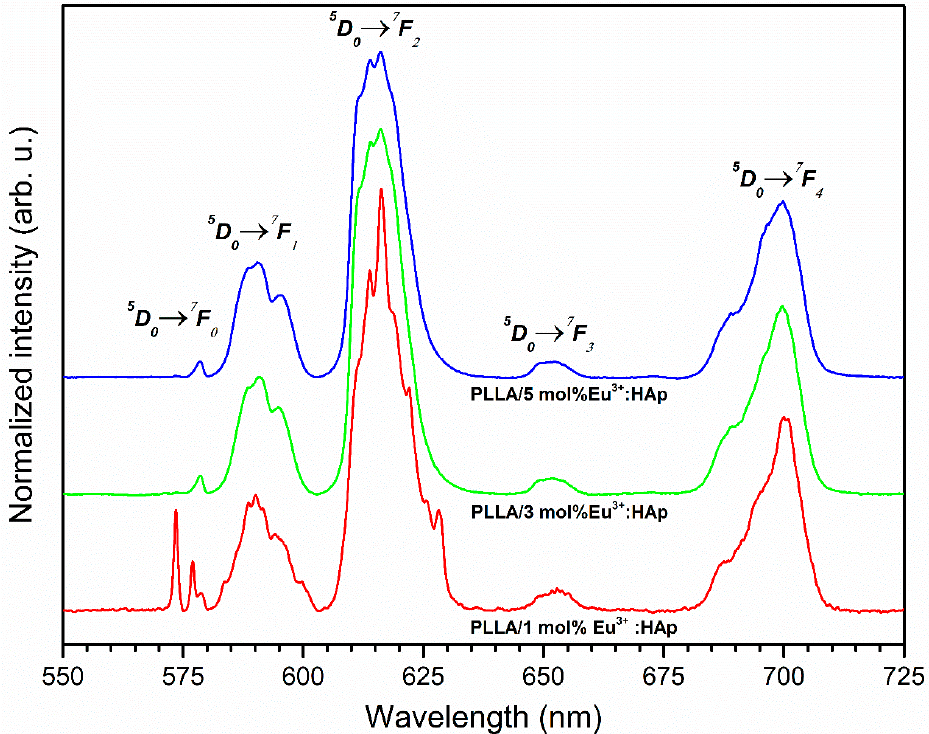
Figure 7. Emission spectra of PLLA/x mol% Eu 3+ :HAp composites (where x = 0–5) incorporated into poly(L-lactide) composites obtained by using the extrusion method . poly(L-lactide) composites obtained by using the extrusion